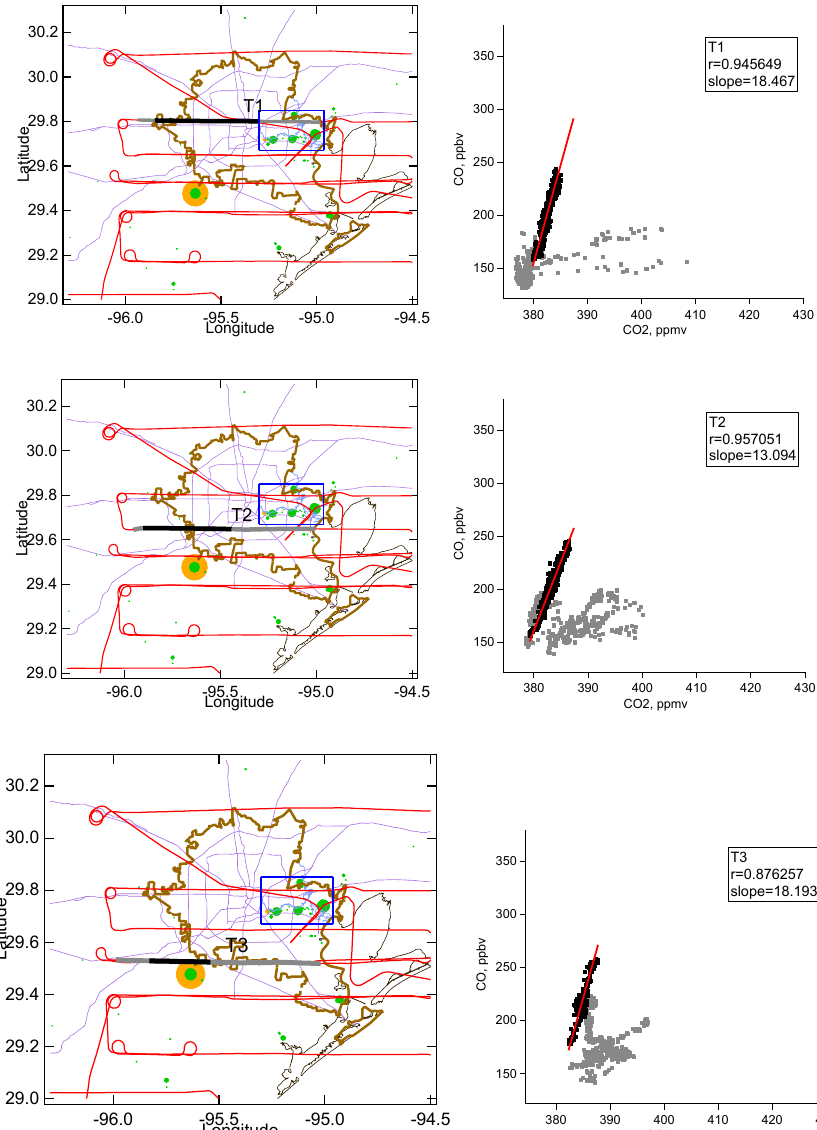
Figure 9. Flight paths and three transects on the map (left) and scatter plots of CO and CO 2 for each transect (right) on 26 September 2006. Transects T1–T3 (gray colored lines) are the same as in Fig. 8. Black lines (left) and dots (right) in the plots represent the flight segments influenced by urban (mobile) sources. Green (orange) colored circles represent NO x (SO 2 ) point sources. Blue box defines the Houston Ship Channel area in this study.